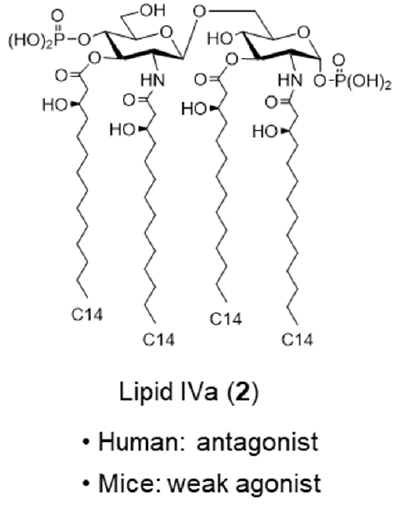
Figure 3. Lipid IVa. TLRs are membrane glycoproteins with a leucine-rich repeat motif in the ectodomain and a cytoplasmic signaling domain homologous to the interleukin-1 receptor (IL-1R) called the Toll/IL-1R (TIR) domain. TLR4 signals are transduced through various adapter molecules (MyD88, TRIF, TIRAP, and TRAM) (Figure 4) [18]. MyD88-dependent signaling triggers the activation of NF- κ B, a transcription factor associated with inflammation, which produces proinflammatory cytokines such as tumor necrosis factor (TNF)- α and IL-6, which in turn induces a defense response against infection. On the other hand, TRIF-dependent signaling activates interferon (IFN) regulator 3 (IRF3), which triggers the production of antiviral cytokine type I IFN. It has also been shown that the canonical E. coli LPS strongly activates both signals simultaneously (Figure 4), causing a severe inflammatory response that results in lethal toxicity. Therefore, it is essential to attenuate the function of lipid A by regulating the TLR4 signaling pathway for the development of lipid A-based